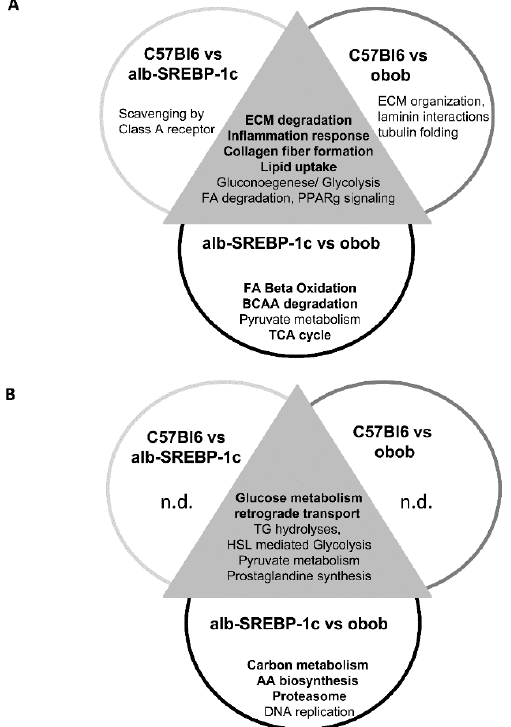
Figure 4. Unique pathways activated by differentially secreted adipokines. The prediction of secretory protein classification as classical SP+/SP- signaling sequences or non-classically secreted proteins was performed with SignalP 4.1 or SecretomeP 2.0, as indicated in the methods section. The functional annotation of differentially abundant proteins was performed separately on ( A ) proteins with classical SP+/SP- signaling sequences and ( B ) non-classically secreted proteins. Abbreviations: AA: amino acids, BCAA: branched chain amino acids; ECM: extracellular matrix; FA: fatty acids; n.d.: not detected, TCA cycle: tricarboxylic acid cycle.